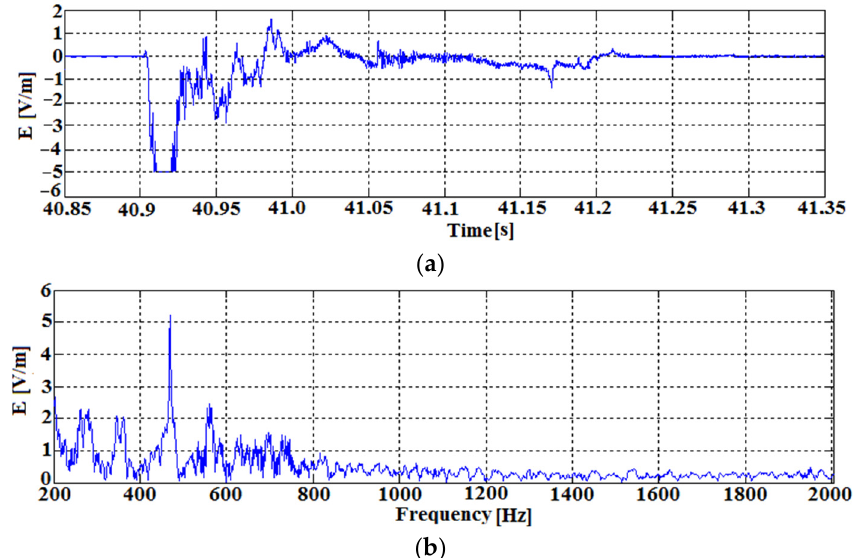
Figure 12. The second recorded pulse from Figure 10 at 40.85 to 41.35 s. (complete destruction of the sample): ( a ) time course; ( b ) spectrum of the